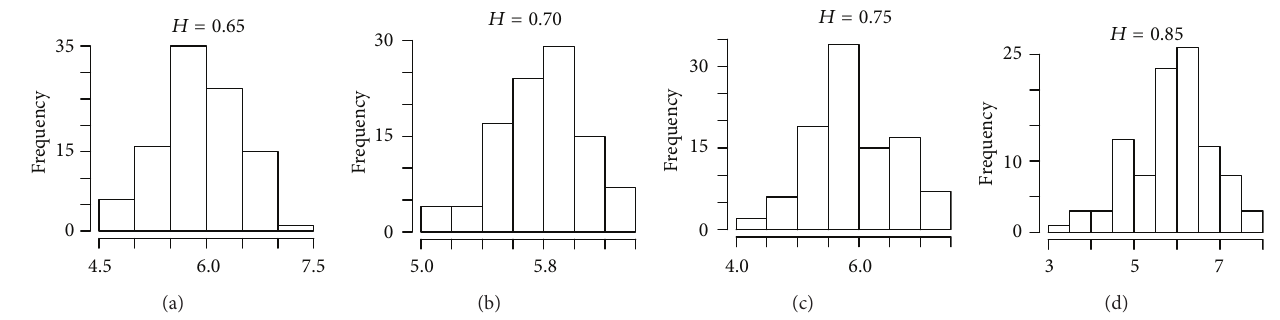
̂𝛽 ( 𝛽 = 5.8215 ) for different values of 𝐻